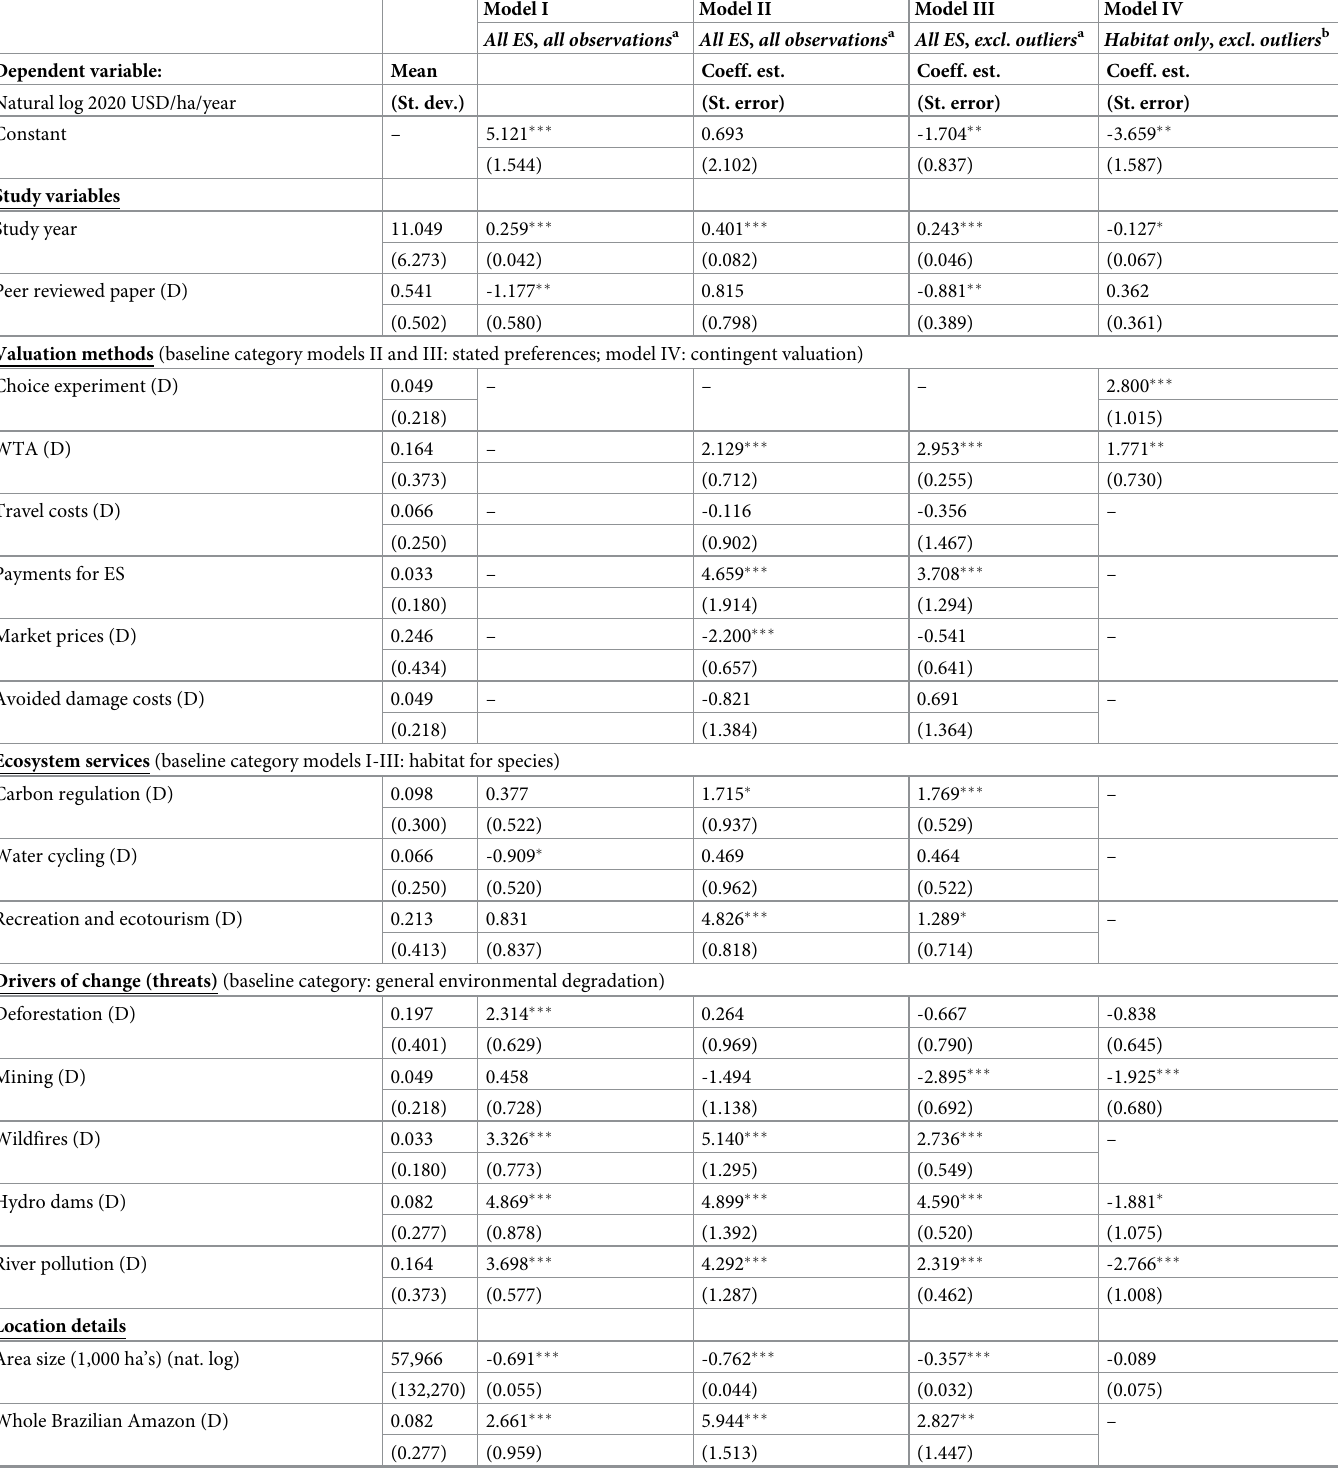
Table 2. Generalized least squares regression